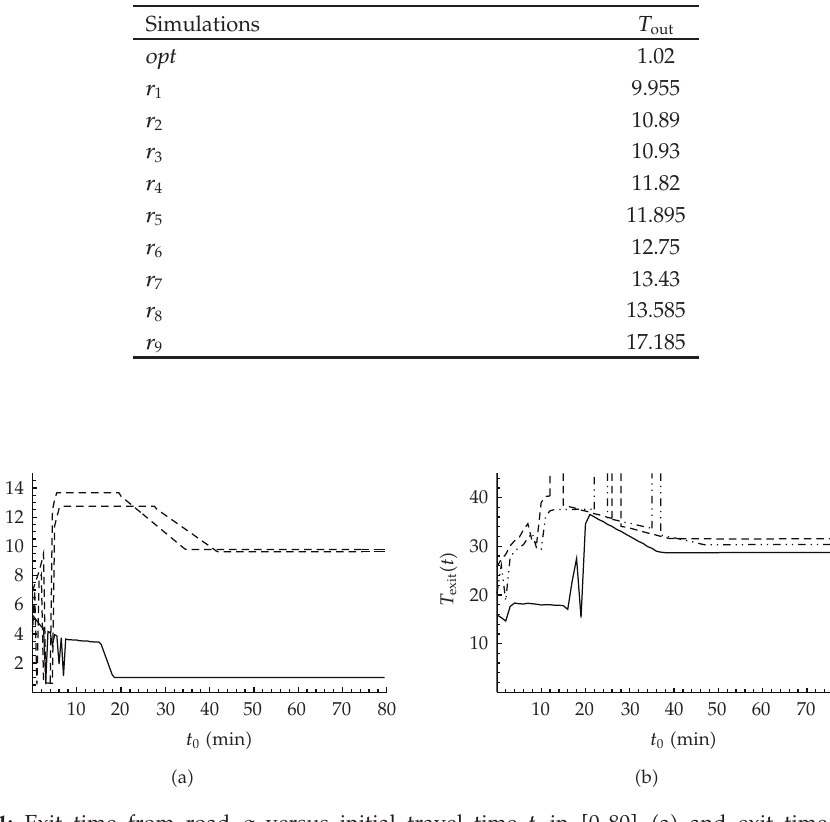
Figure 11: Exit time from road g versus initial travel time t 0 in (cid:5) 0 , 80 (cid:6) (cid:4) a (cid:7) and exit time from the path (cid:4) a,g,h,l (cid:7) versus initial travel times t 0 in (cid:5) 0 , 80 (cid:6) (cid:4) b (cid:7) , evaluated for optimal distribution coe ffi cients (cid:4) continuous lines (cid:7) and random choices (cid:4) dashed and dot dashed lines (cid:7)